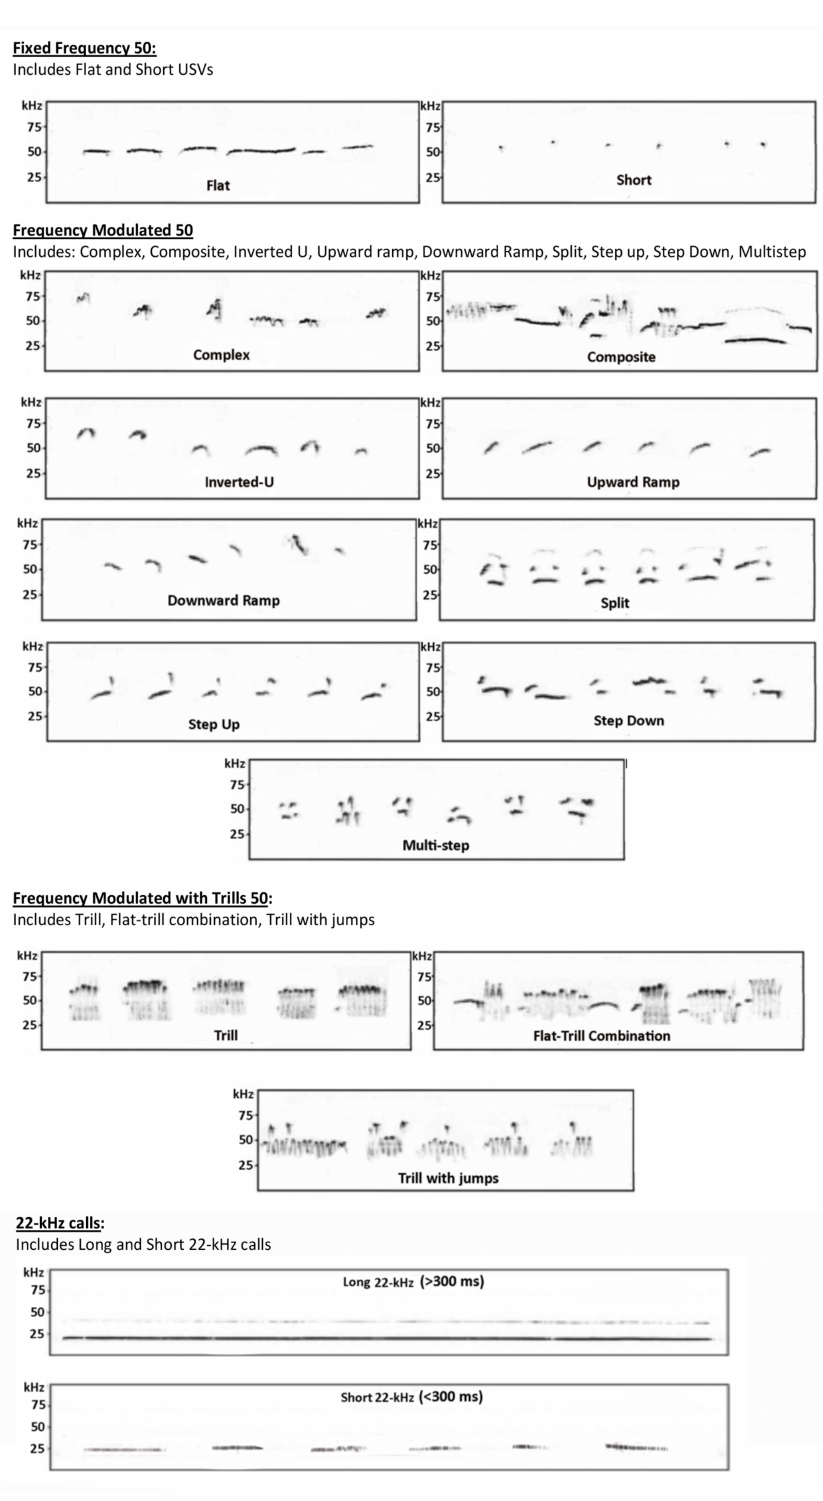
Figure 1. Representative spectrograms for each of the call types in Table